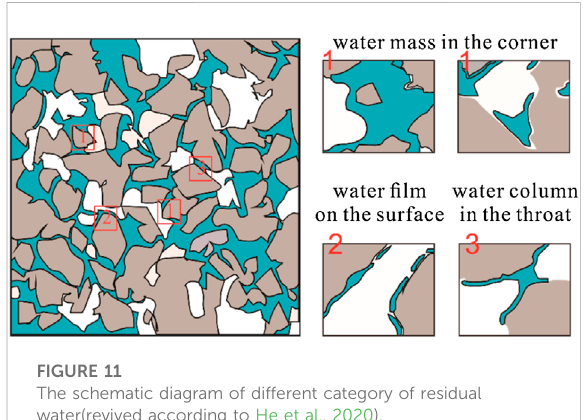
FIGURE 11 The schematic diagram of different category of residual water(revived according to He et al., 2020).